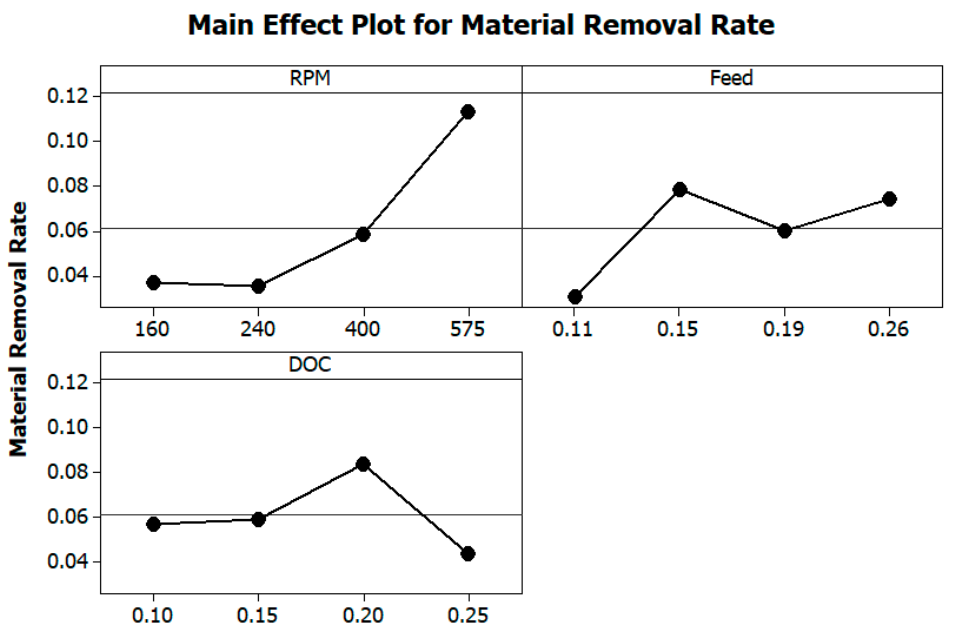
Figure 1. E ff ects of turning parameters on material removal rate (MRR). Figure 1. Effects of turning parameters on material removal rate (MRR).